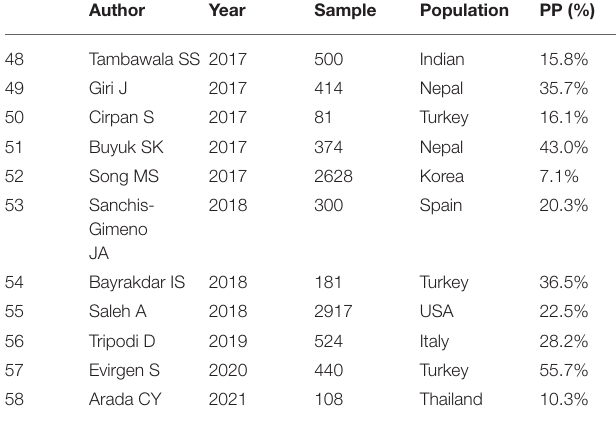
TABLE 1 | Review of the literatures on prevalence of